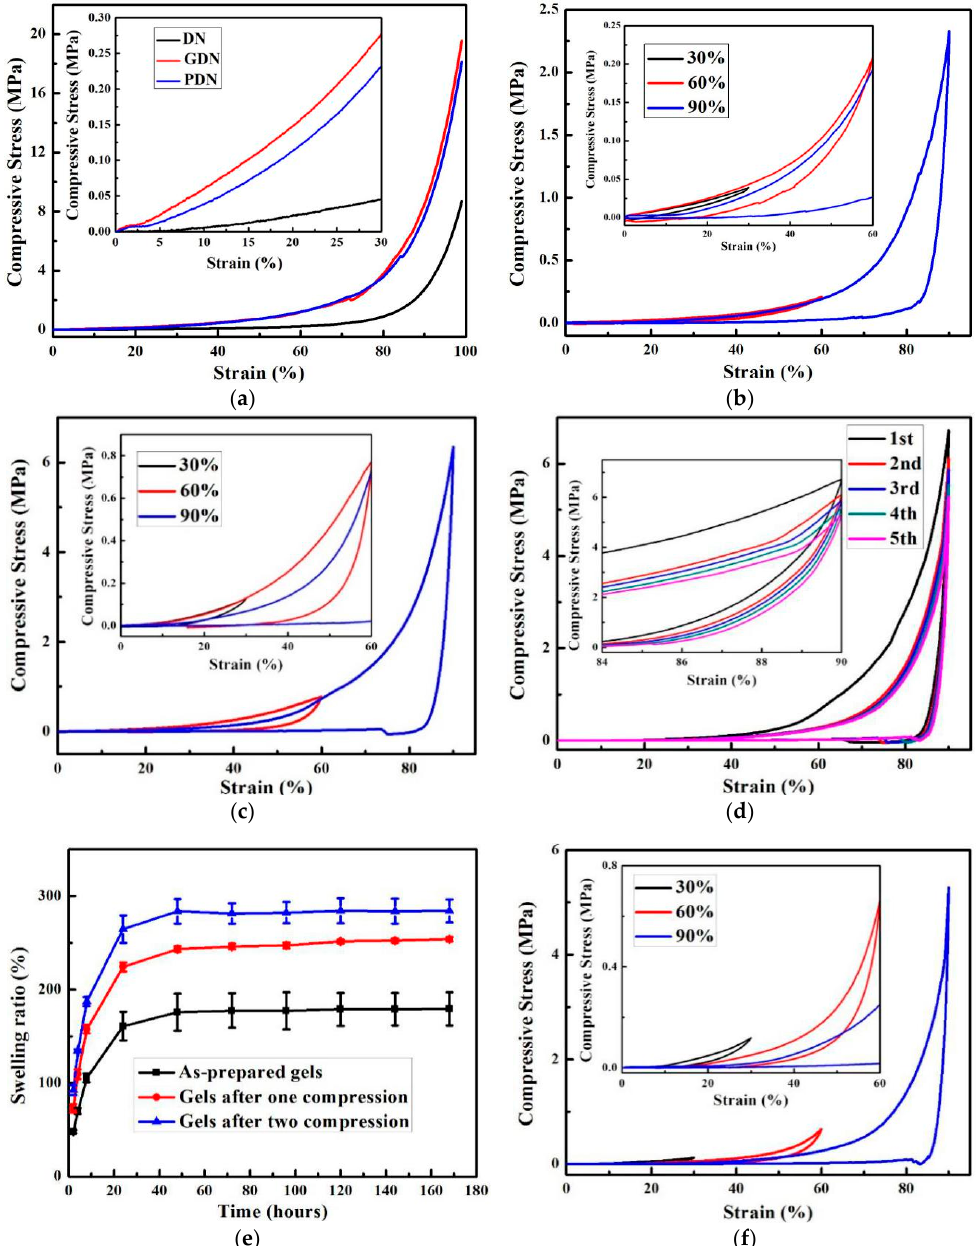
Figure 4. ( a ) Normal stress-strain curve of DN, GDN, and PDN hydrogels, and the typical consecutive loading-unloading curves of ( b ) DN and ( c ) PDN hydrogels with the gradient increased in maximum strain (30%, 60%, and 90%), ( d ) representative cyclic loading-unloading curves of PDN hydrogels for up to five cycles at 90% strain compression, ( e ) swelling ratio of as-prepared gels, gels after one compression, and gels after two compression, and ( f ) the hysteresis loops at the fifth loading cycle at different maximum strains of PDN gels.